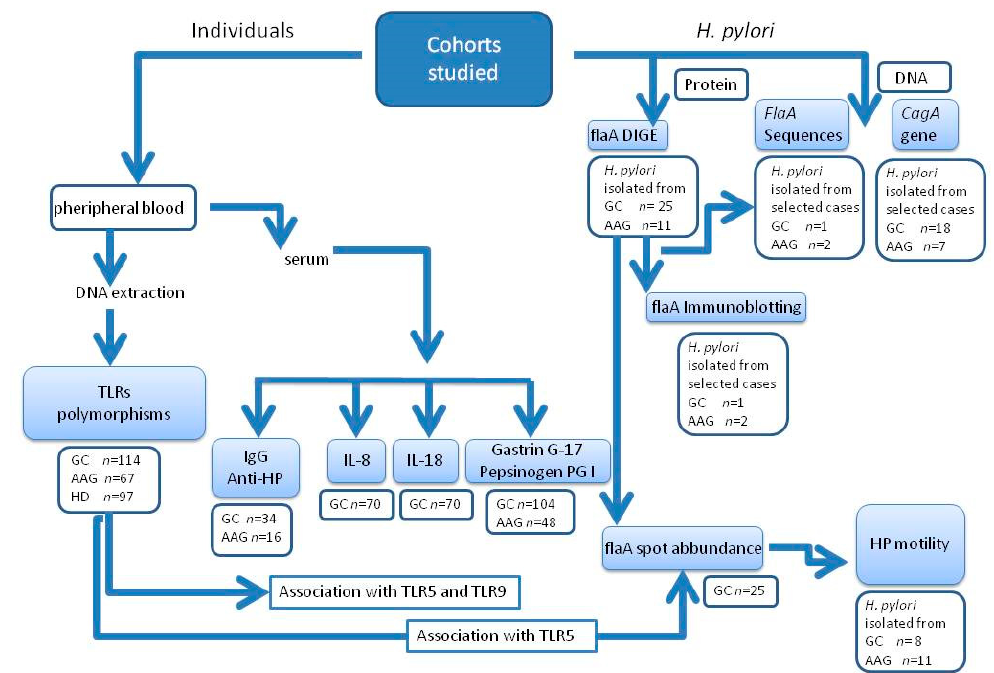
Figure 1. Flow diagram of the study design. 2 patients’ groups (GC and AAG), as well as healthy donors (HD) were analyzed for TLR polymorphisms (rs were listed in Table 2) and serological markers for H. pylori (HP) infection. H. pylori-related pro-inflammatory interleukin (IL)-8 and IL-18 cytokines were tested in GC and in association with the respective toll-like receptor (TLR)5 and TLR9 patient’s genotype. Gastrin G-17, PG-I and H. pylori -like markers for AAG and GC risk, were